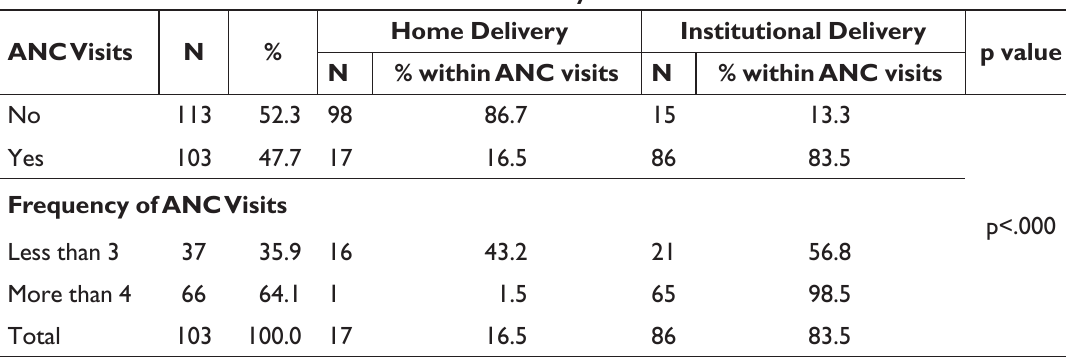
Ante Natal Care Visits and Place of Delivery ANC